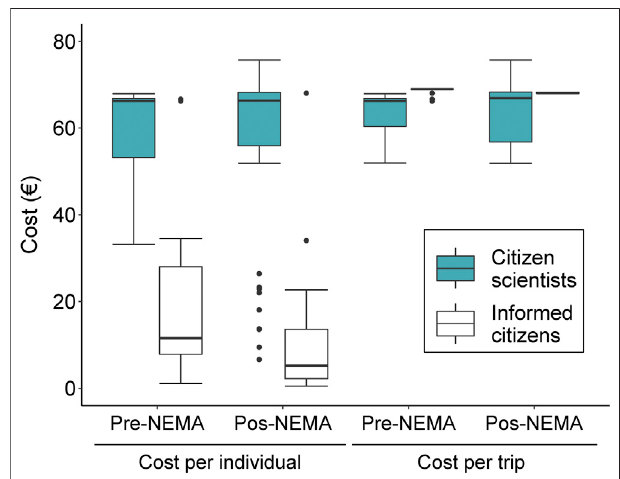
FIGURE 8 | Minimum cost for a scientist to obtain the same 166 observations (1747 Atlantic blue crabs) submitted by informed citizens and citizen scientists before (April 2018-March 2019) and during the NEMA campaign (April 2019-March 2020). These are minimum costs, as they only include transportation costs and the daily value of a Ph.D. fellowship of one